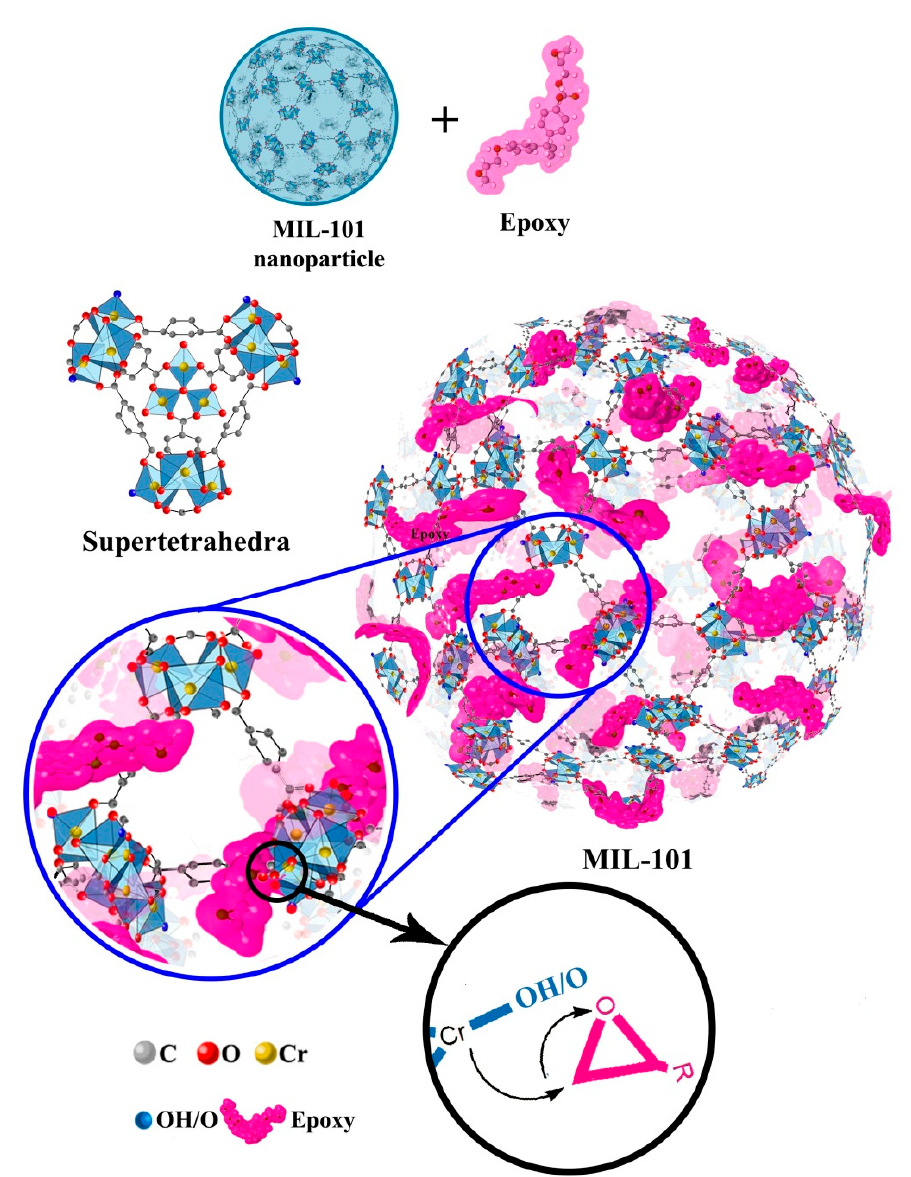
Figure 4. The possible reaction between the MIL-101 MOF and the epoxy resin and the schematic view of the diffusion of epoxy into the pores of MOF [70] . Similar to the outcome of studies performed on halloysite nanotubes (HNTs), using the potential of inner functional groups (in the case of HNTs, inside the nanotubes and in the case of MOF, inside the nanocages) has a significant effect on the crosslinking of epoxy resin. In fact, functional groups contributed to curing reactions from the internal surface of minerals (denoted as secondary curing agents or extra cure sites) keeping the stoichiometry balanced when gelation takes place. Above conversion of gelation ( α g ), curing agent molecules can hardly access the epoxide groups; therefore, curing will remain incomplete as a consequence of contacts between cure moieties being substantially limited or even stopped. In such a situation, the excess sites contributed from reactive groups of internal structure compensate for incomplete cure arising from gelation. MOF has a high potential for being considered as such a highly reactive mineral.